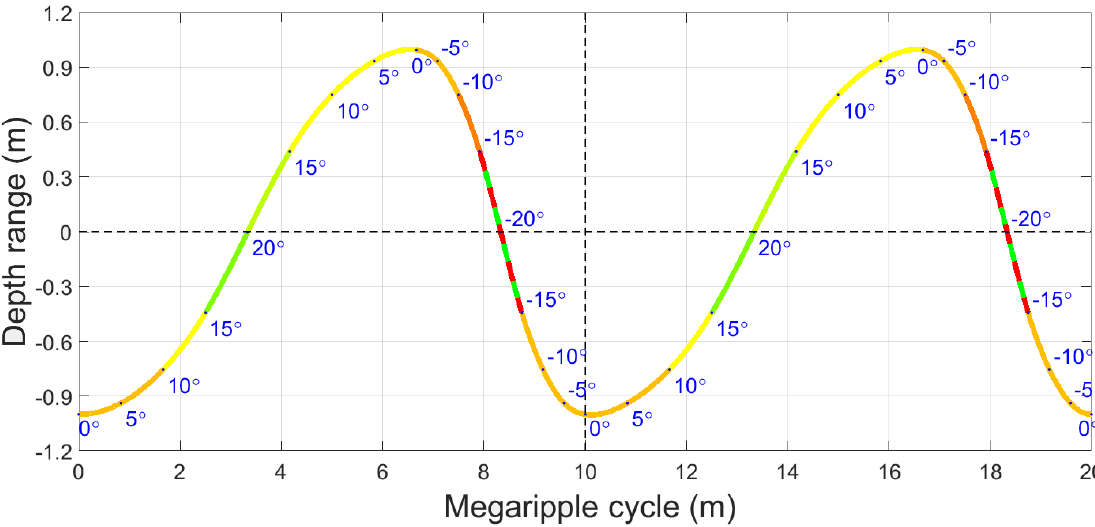
Figure 20. Schematic sedimentary composition of megaripple migrating to right; wavelength is 10 m and depth variation is ± 1 m. Colors represent interpolated classes among class numbers 1, 2, 3, and 4; dashed green-red lines indicate all variants of sediment types (from fine to